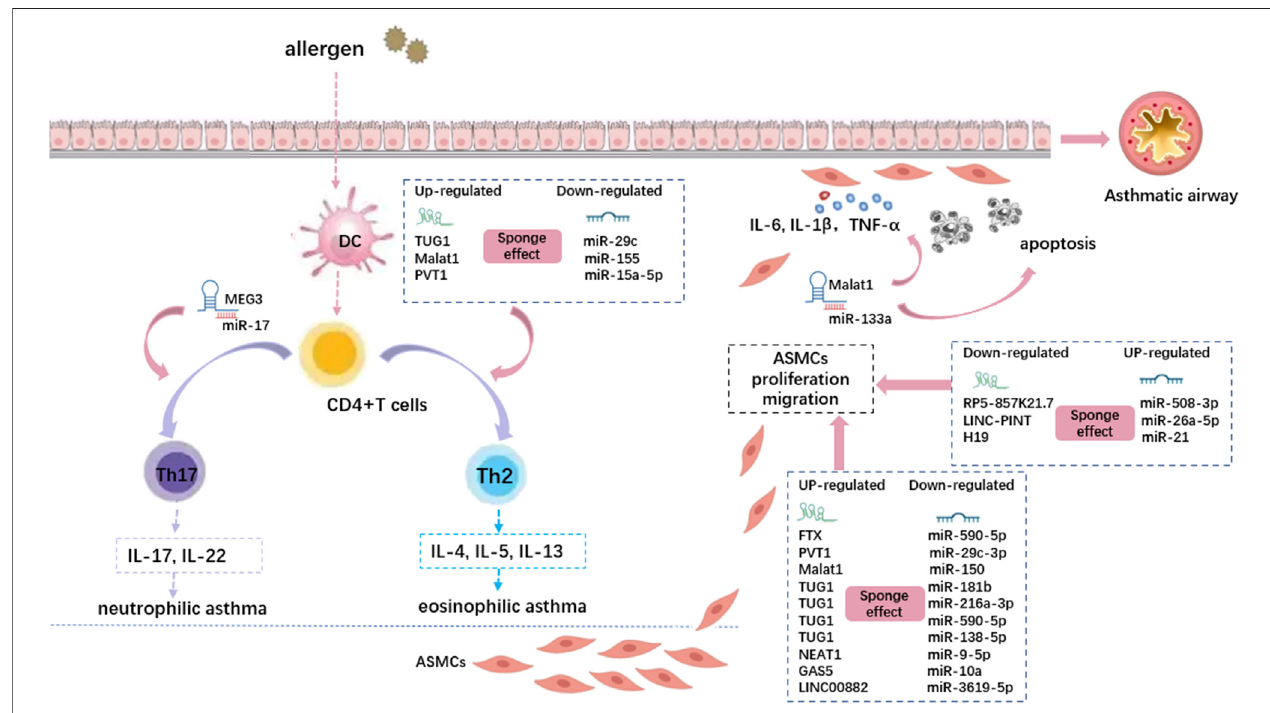
FIGURE 3 | The lncRNA-miRNA crosstalk is involved in the pathogenesis of asthma by regulating CD4 + T cells and airway smooth muscle cells. Different lncRNAs regulate different miRNAs through the sponge effect, and then inhibit Mrna. The dotted boxes in the picture show typical lncRNA-miRNA interactions that function in asthma, which correspond to the cellular process they act on through pink arrows. DC: Dendritic cell; ASMCs: airway smooth muscle